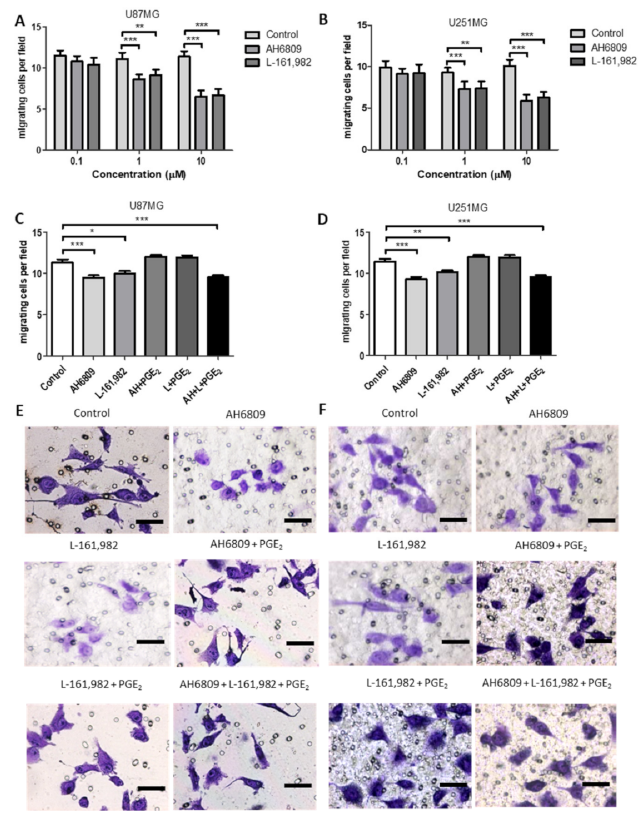
Figure 7. Effects of EP2 or EP4 receptor antagonists, AH6809 and L-161,982, on GBM cell migration in the presence or absence of exogenous PGE 2 . Graphs show the results of EP receptor antagonism in the absence or presence of exogenous PGE 2 . Cells were treated for 12 h with EP receptor antagonists in ( A , B ). ( A ) Concentration dependent inhibition of cell migration by EP2 or EP4 antagonists in U87MG; ( B ) Concentration dependent inhibition of cell migration by EP2 or EP4 antagonists in U251MG; Cells were treated for 1 h with EP receptor antagonists before addition of PGE 2 for an additional 11 h, totalizing 12 h treatment with antagonists in C-F. ( C ) EP receptor antagonists in the absence or presence of exogenous PGE 2 in U87MG cells; ( D ) EP receptor antagonists in the absence or presence of exogenous PGE 2 in U251MG cells; ( E ) Images of transwells for U251MG control, AH6809 (1 µ M), L-161,982 (1 µ M), AH6809 (1 µ M) + PGE 2 (5 µ M), L-161,982 (1 µ M) + PGE 2 (5 µ M) and AH6809 (1 µ M) + L-161,982 (1 µ M) + PGE 2 (5 µ M) treatments; ( F ) Images of transwells for U251MG control, AH6809, L-161,982, AH6809 + PGE 2 , L-161,982 + PGE 2 and AH6809 + L-161,982 + PGE 2 treatments. Data are presented as mean + SEM, n = 3, in triplicate. A two-way ANOVA with a Bonferroni post-test was performed. Differences were considered significant at p < 0.05. * = p < 0.05; ** = p < 0.01; *** = p < 0.001. Scale bar in E and F = 30 µ